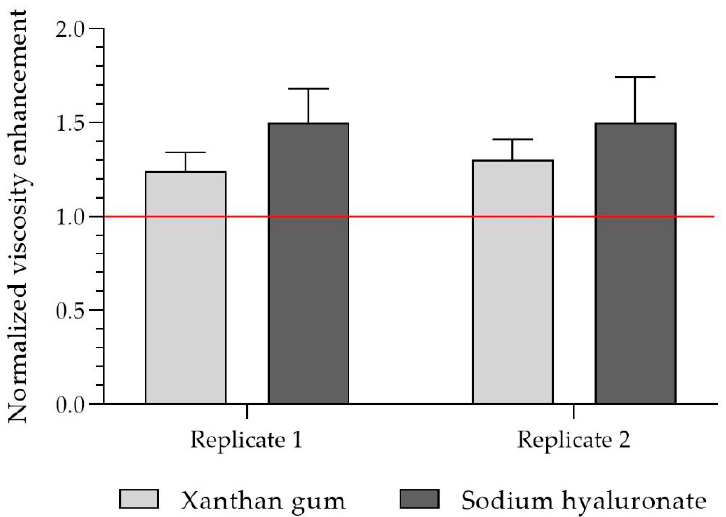
Figure 12. Determination of synergism of xanthan gum (light grey) and sodium hyaluronate (dark grey) with porcine mucin in relation to the viscosities in artificial saliva, incubation time of 10 min, mean ± standard deviation of the independent test runs with two repetitions, mean of all determined data for normalized viscosity enhancement over a shear rate range of 1–100 s − 1 , and the limit value for synergism is indicated by a red